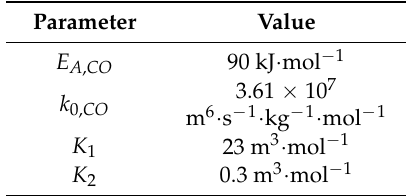
Figure 2. Influence of CO 2 addition on the CO conversion and comparison of experimental data and kinetic model, Equations (4) and (6). The CO 2 conversion is also indicated for experiments with CO 2 addition (1.13 vol% CO, 10% H 2 O, 55% H 2 , 0 ‒ 18% CO 2 , rest N 2 , m cat = 2 g, p = 1 bar, τ (190 °C) = 260 kg s · m − 3 ). The equation describing the CO 2 methanation, which was used here to calculate the CO 2 conversion is introduced in Section 3.2. Table 2. Parameters of the kinetics of CO methanation (see Equations (4) and (5)).